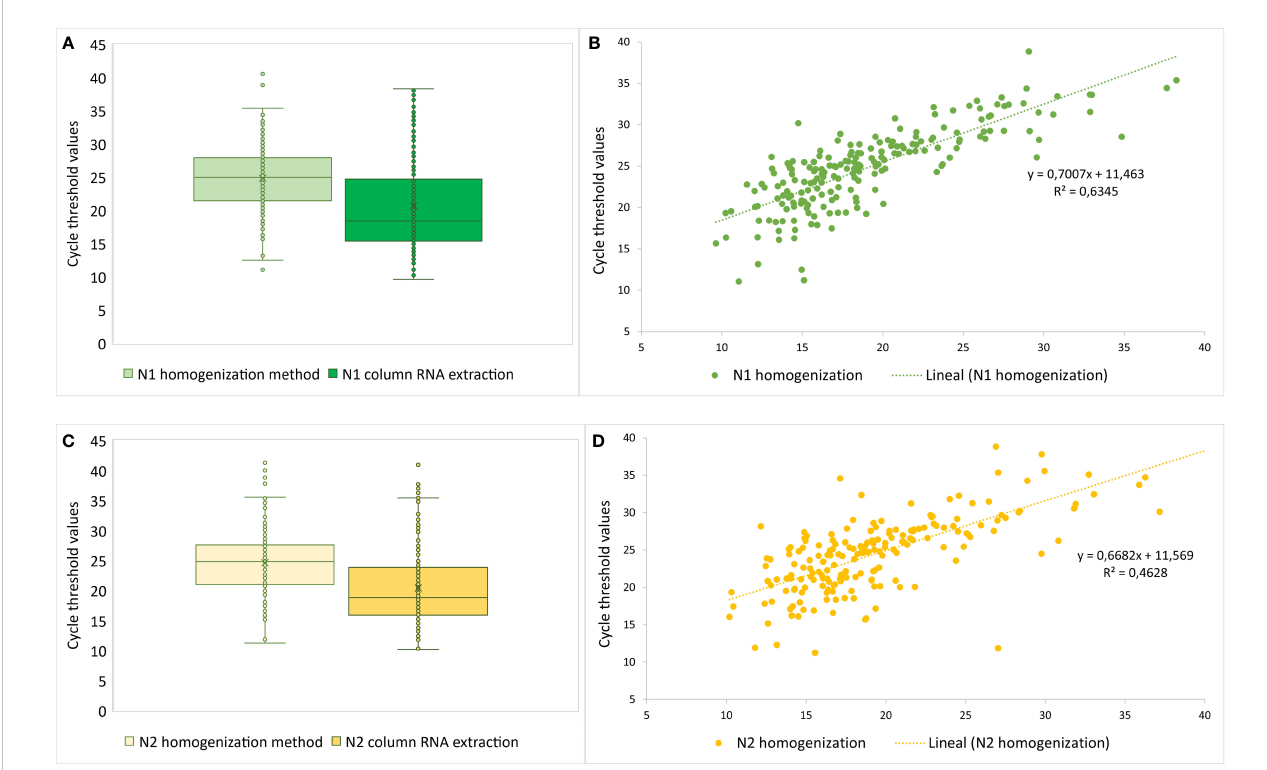
FIGURE 2 (A-C) Average Ct values obtained for N1 and N2 genes using homogenization method vs column RNA extraction (gold standard); (B-D) Linear plots for Ct values for N1 and N2 genes for RNA extraction versus homogenization method.